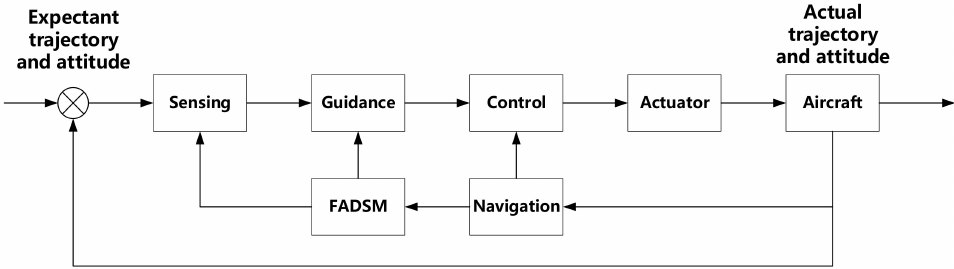
Figure 31. Block diagram of an aircraft with high performance GNC system based on online calcu- lated atmospheric